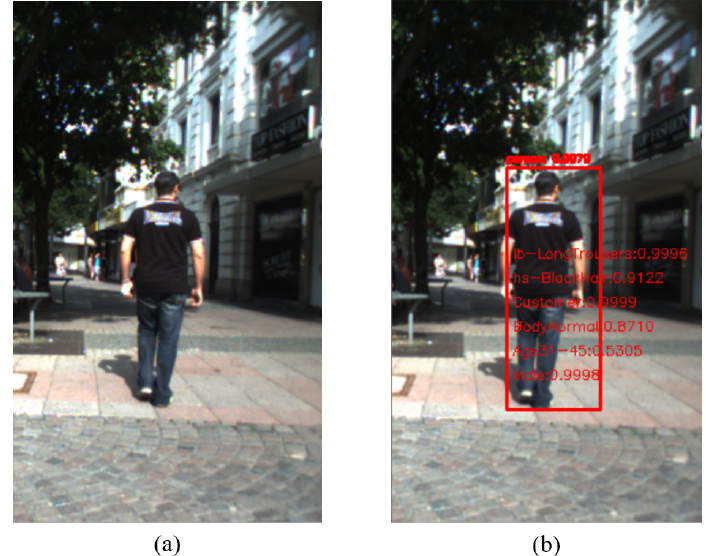
Figure 19. Demonstration of our proposed framework: ( a ) input image; ( b ) output